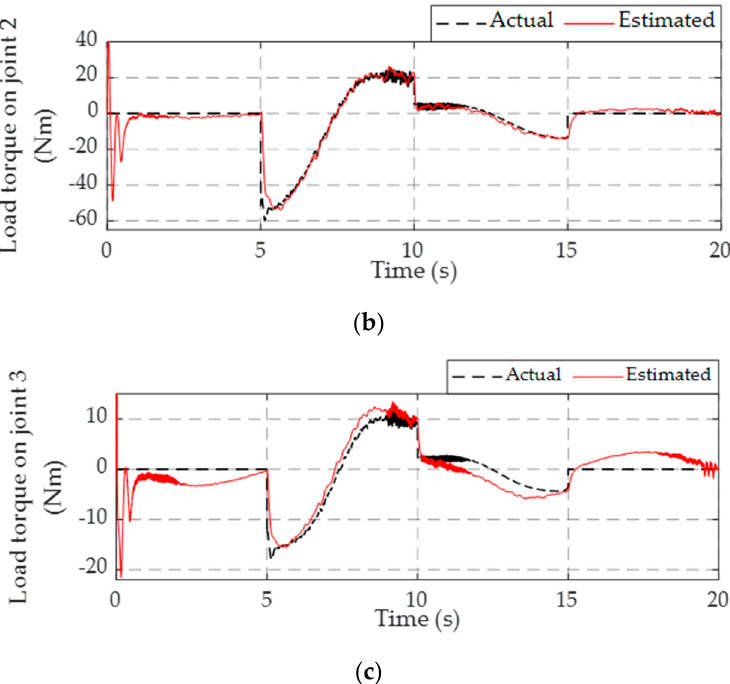
Figure 14. The load torque estimated of the: ( a ) first joint, ( b ) second joint, and ( c ) third joint.